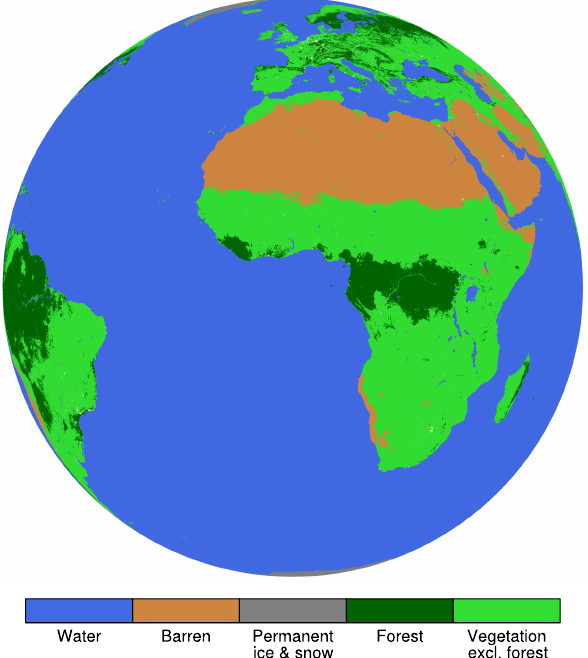
Figure 2. Visualisation of the geographical coverage of the five sur- face type classes across the SEVIRI